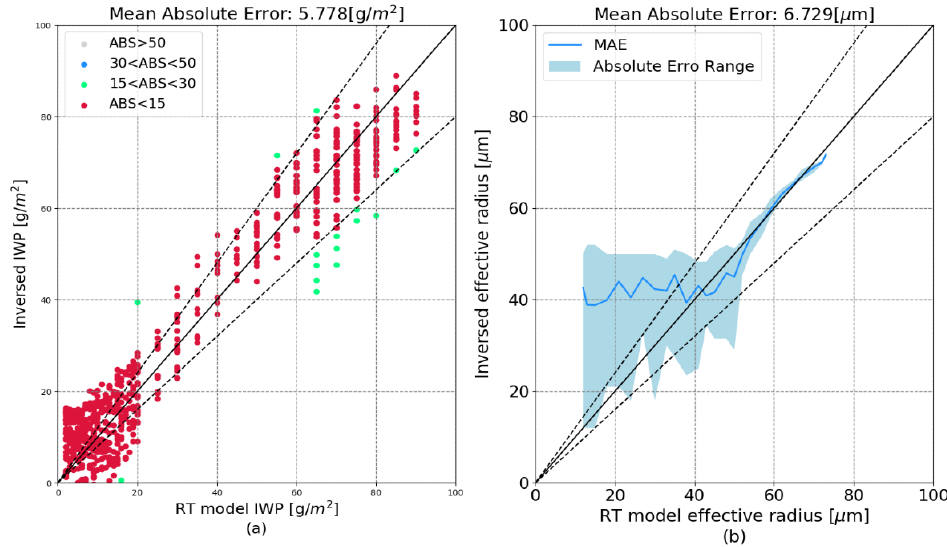
Figure 7. Inversed IWP and D me from the dual-channels algorithm. ( a ) Inversed IWP; ( b ) inversed D me .